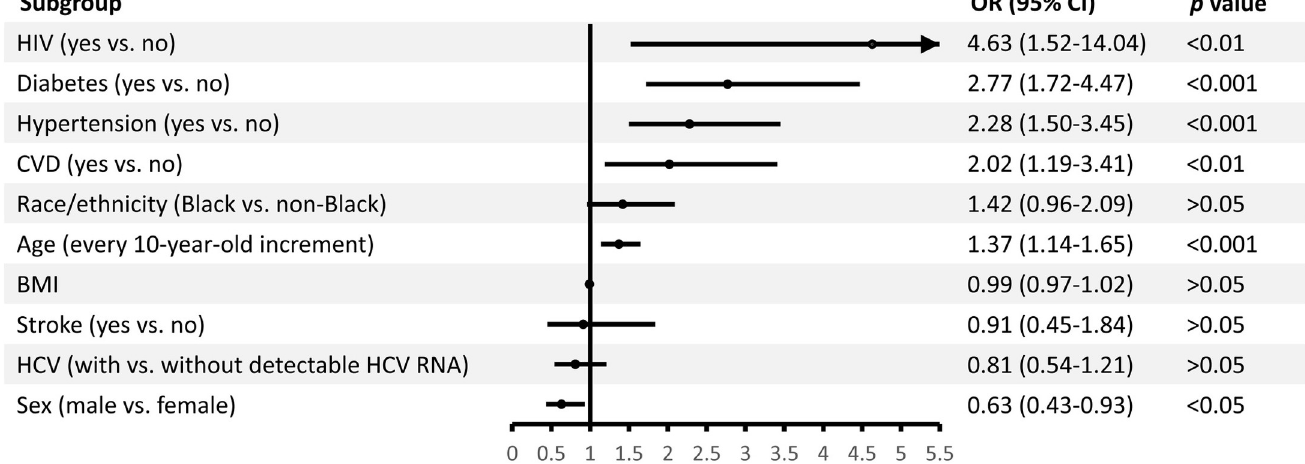
PLOS ONE | https://doi.org/10.1371/journal.pone.0271197 July 8,